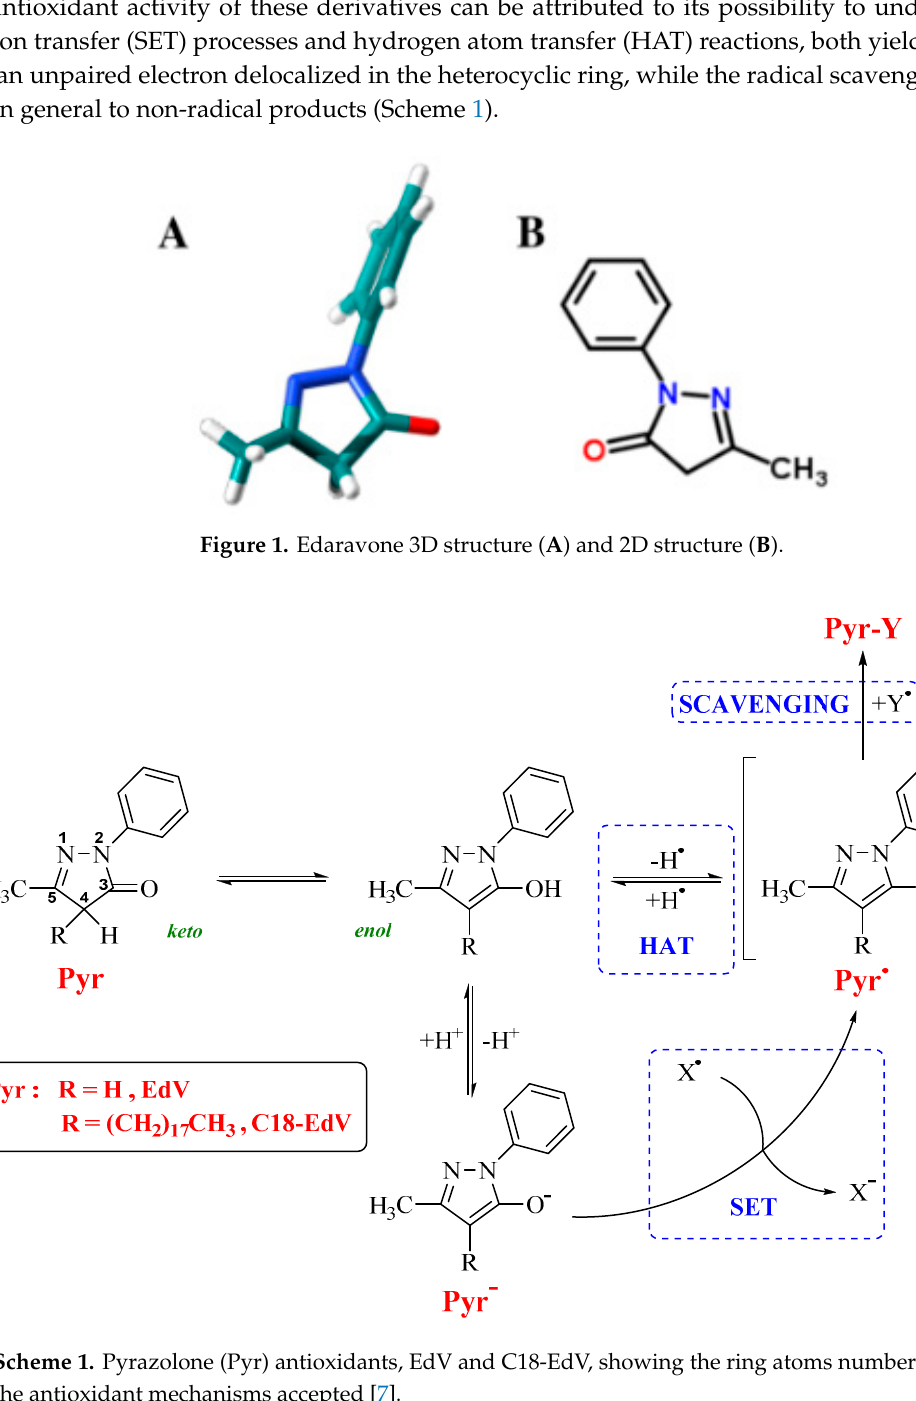
Figure 1. Edaravone 3D structure ( A ) and 2D structure ( B